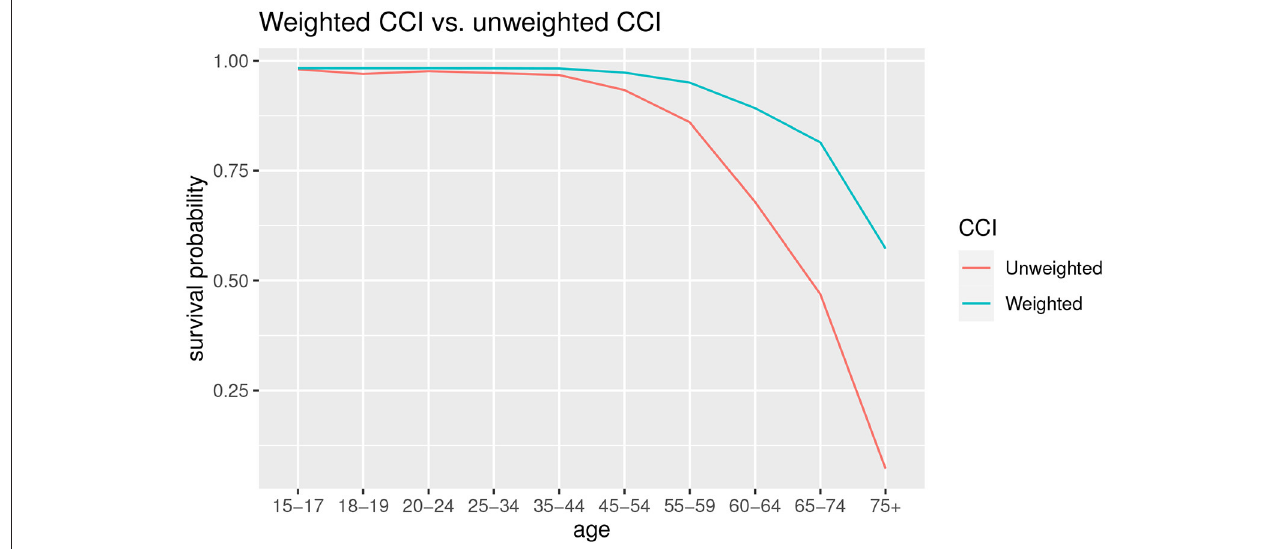
FIGURE 5 | Survival probability with weighted CCI and unweighted CCI.